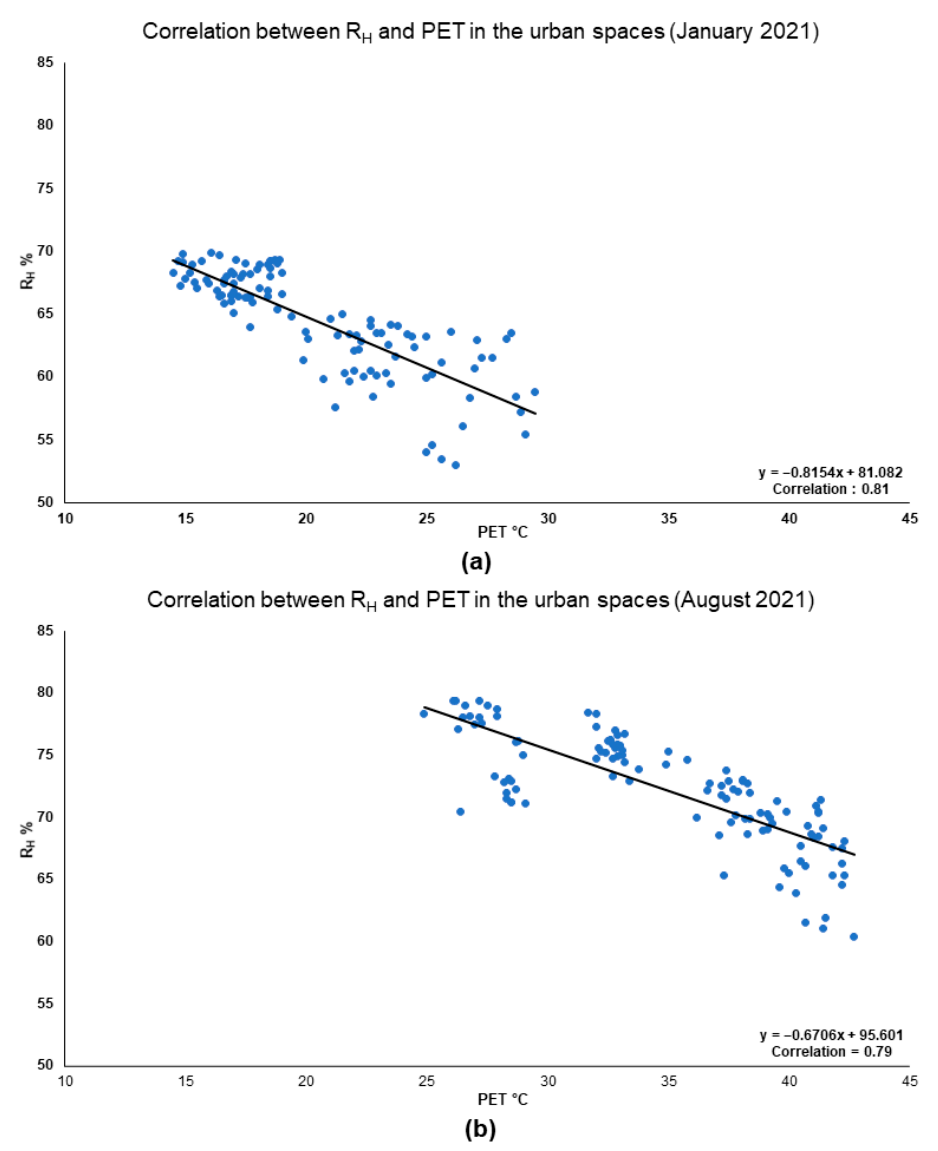
Figure 9. Overall correlation between relative humidity and PET at the 14 points studied in January ( a ) and August ( b ).